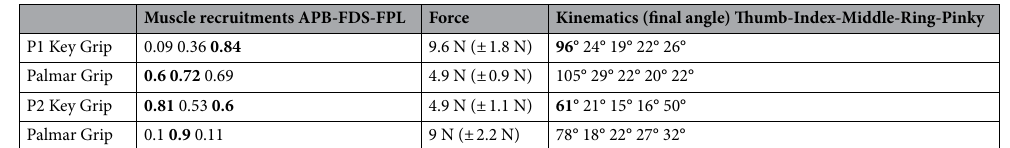
Table 2. Combined assessment of grasping movements. Significant values are in